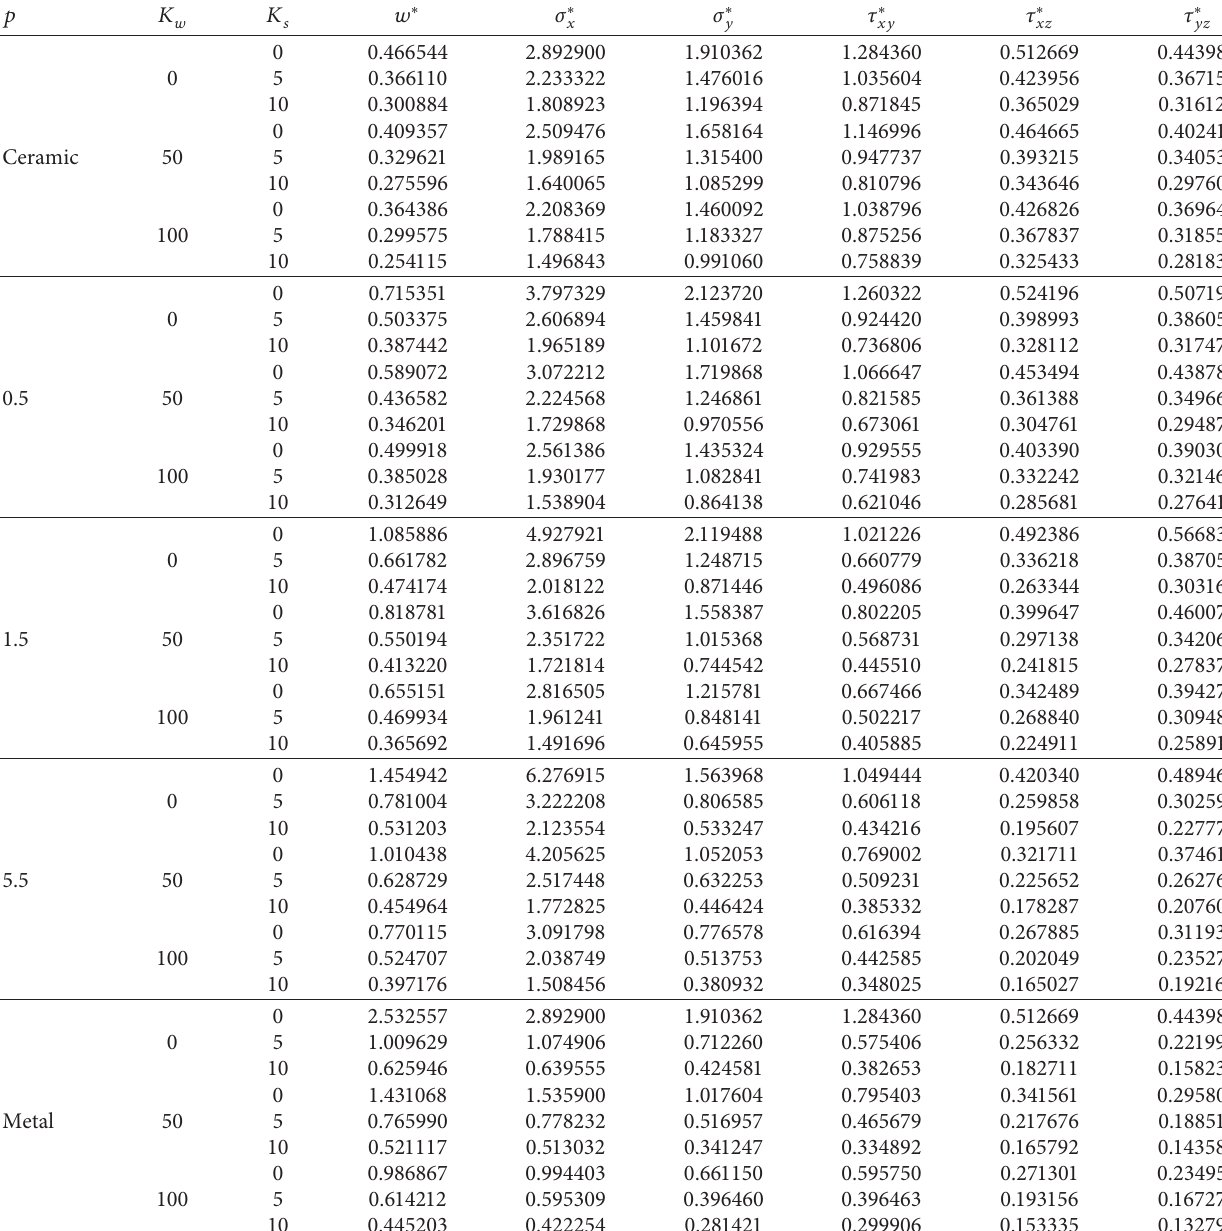
Table 7: The influence of two elastic foundation parameters on the deflection and stresses of the